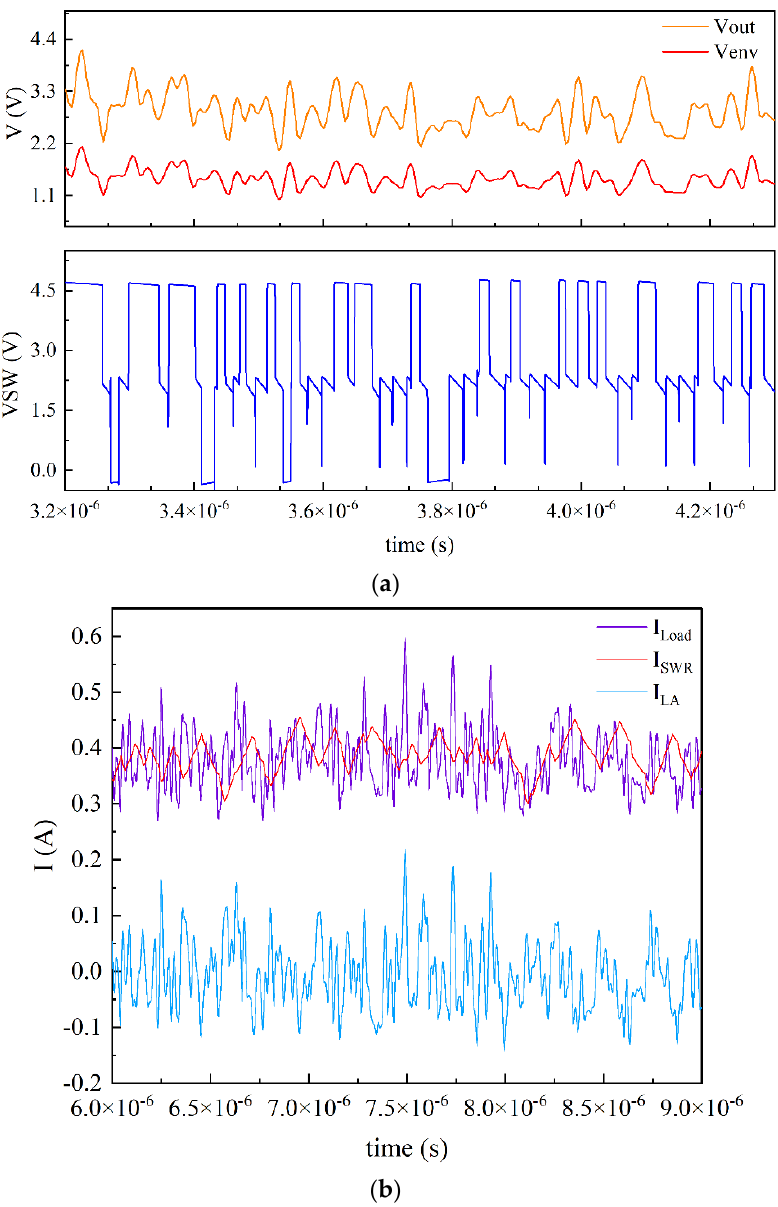
Figure 14. Transient simulation result of ET modulator for 100 MHz input signal: ( a ) input and output waveforms, 3L operation; ( b ) LA output current I LA , SWR output current I SWR , total output current I Load .